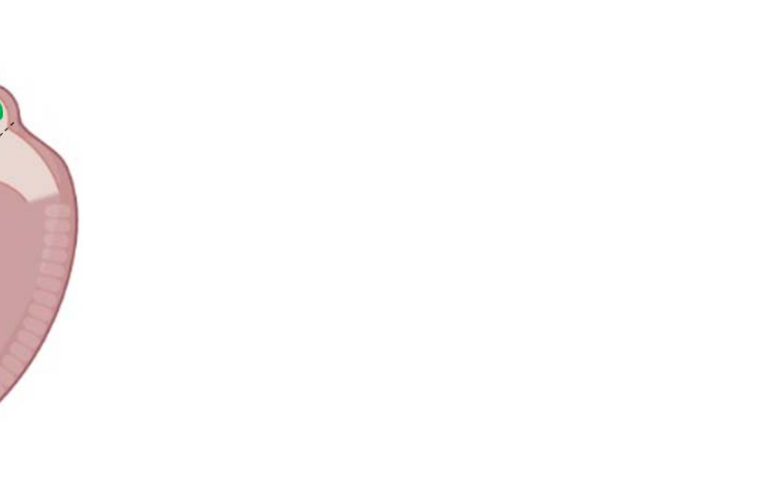
Figure 12. Scheme for obtaining the ventral mesencephalon (blue spot)—the anlage of the substantia nigra, the metencephalon—the anlage of the raphe nucleus (red spot), and the locus coeruleus (green spot) in mice on the 13th embryonic day. Modified from